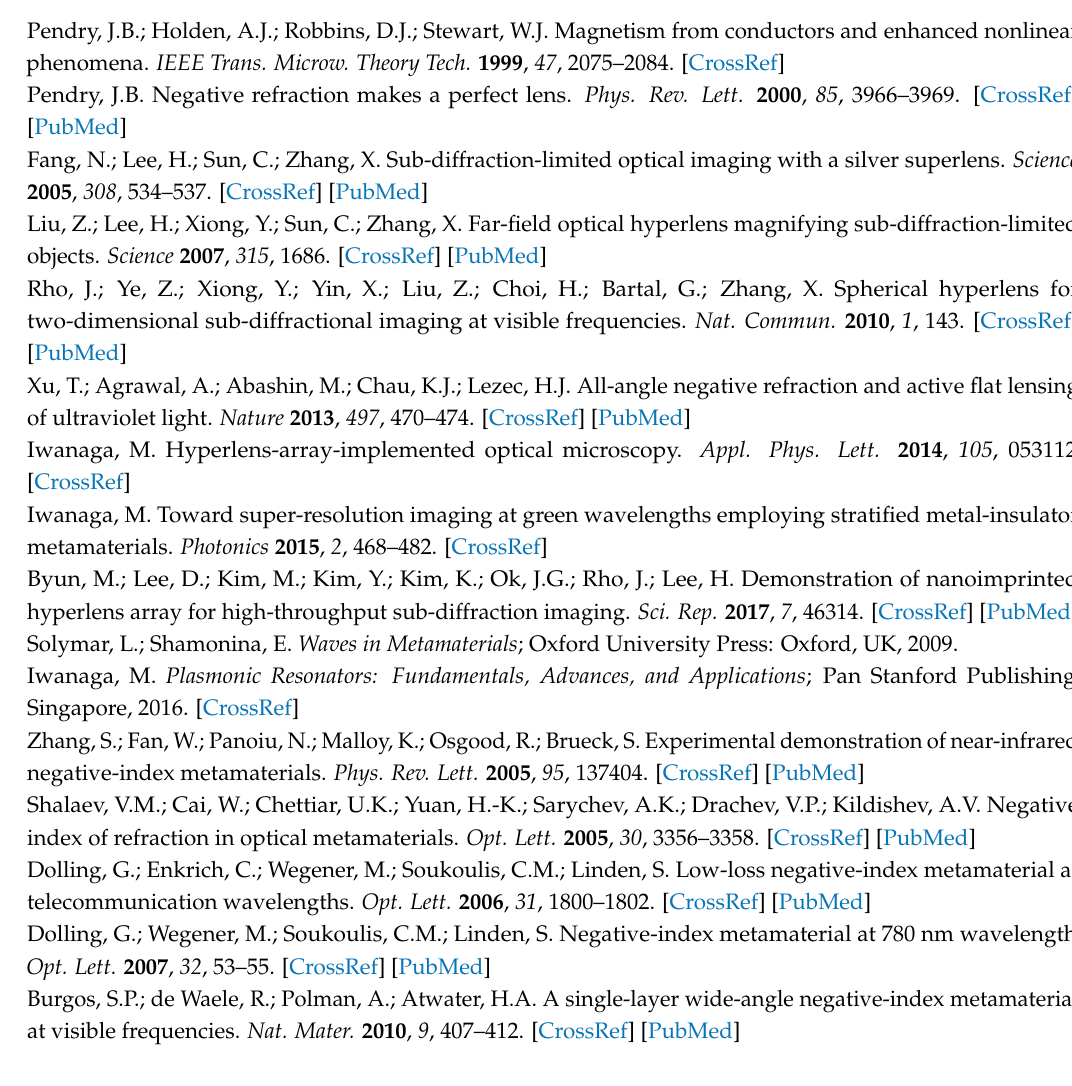
Figure S1: EM-field distributions at the magnetic-dipole resonance associated with the first R peak in Figure 1. Figure S2: EM-field distributions at the electric-dipole resonance at the first T peak (or R dip) in Figure 1. Figure S3: EM-field distributions at the 1-wavelength guided resonance associated with the second T peak (or R dip) in Figure 1. Figure S4: EM-field distributions at a higher magnetic resonance associated with the third R peak in Figure 1. Figure S5: Comparison of R spectra of the Si-rod-array metasurface and the SOI-based metasurface. Figure S6: | E | distributions at the excitation wavelength of 532.0